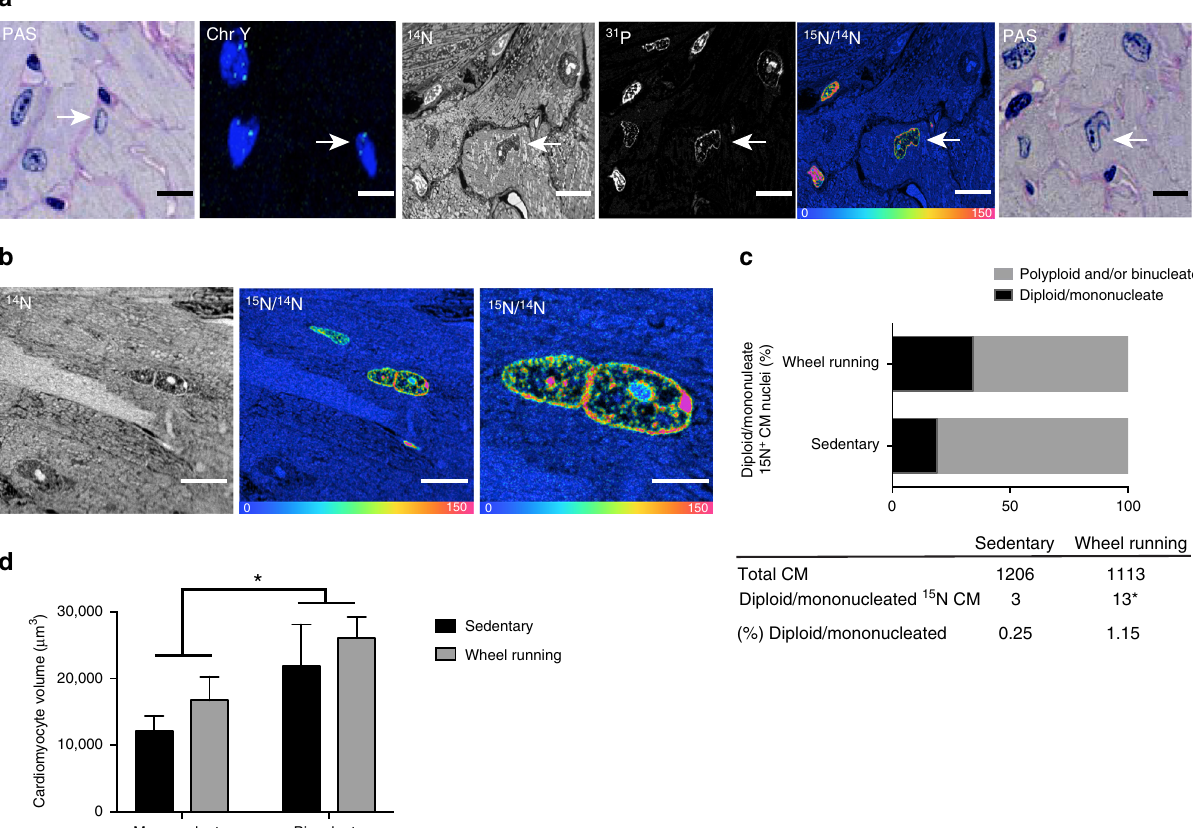
Fig. 2 Number of mononucleate diploid 15 N-labeled cardiomyocytes increases with exercise. a Serial sections (0.5 – 1 μ m thickness) were processed to determine the ploidy status and number of nuclei of each 15 N-labeled cardiomyocyte (large white arrow). Periodic acid Schiff staining (PAS) was performed on serial adjacent sections in both directions from the MIMS chip to de fi ne the number of nuclei contained in the cell and fl uorescent in situ hybridization (Y-chromosome) was performed to identify ploidy status. A representative image series is shown from a mononucleate (PAS staining far left/right, scale bar = 10 μ m) diploid (2 N, second from left, scale bar = 5 μ m) 15 N-labeled (MIMS second from right, scale bar = 10 μ m) cardiomyocyte. 14 N and 31 P images are shown for subcellular resolution (center, scale bar = 10 μ m). b Representative image of a 15 N-labeled cardiomyocyte nuclei undergoing binucleation. Scale bar = 10 μ m for mass image 14 N and 15 N/ 14 N (left, center). Scale bar = 4 μ m for mass image 15 N/ 14 N (right). c Bar graph showing the frequency of mononucleate/diploid vs. polyploid and/or multinucleate 15 N-thymidine-labeled cardiomyocytes from each group (graph) and contingency table showing absolute numbers and percentage calculations of 15 N-positive and all identi fi ed cardiomyocytes (sedentary: exercised = 0.25%:1.15%, n = 4 mice per group, * p = 0.01, Fisher ’ s exact test, OR = 4.695, CI 1.44 – 15.53). d Mononucleate 15 N-thymidine labeled cardiomyocytes were signi fi cantly smaller than their binucleate counterparts in the same hearts ( n = 3 mice per group, one-way ANOVA with Tukey ’ s correction for multiple comparisons (signi fi cance level p < 0.05). Error bars represent ±